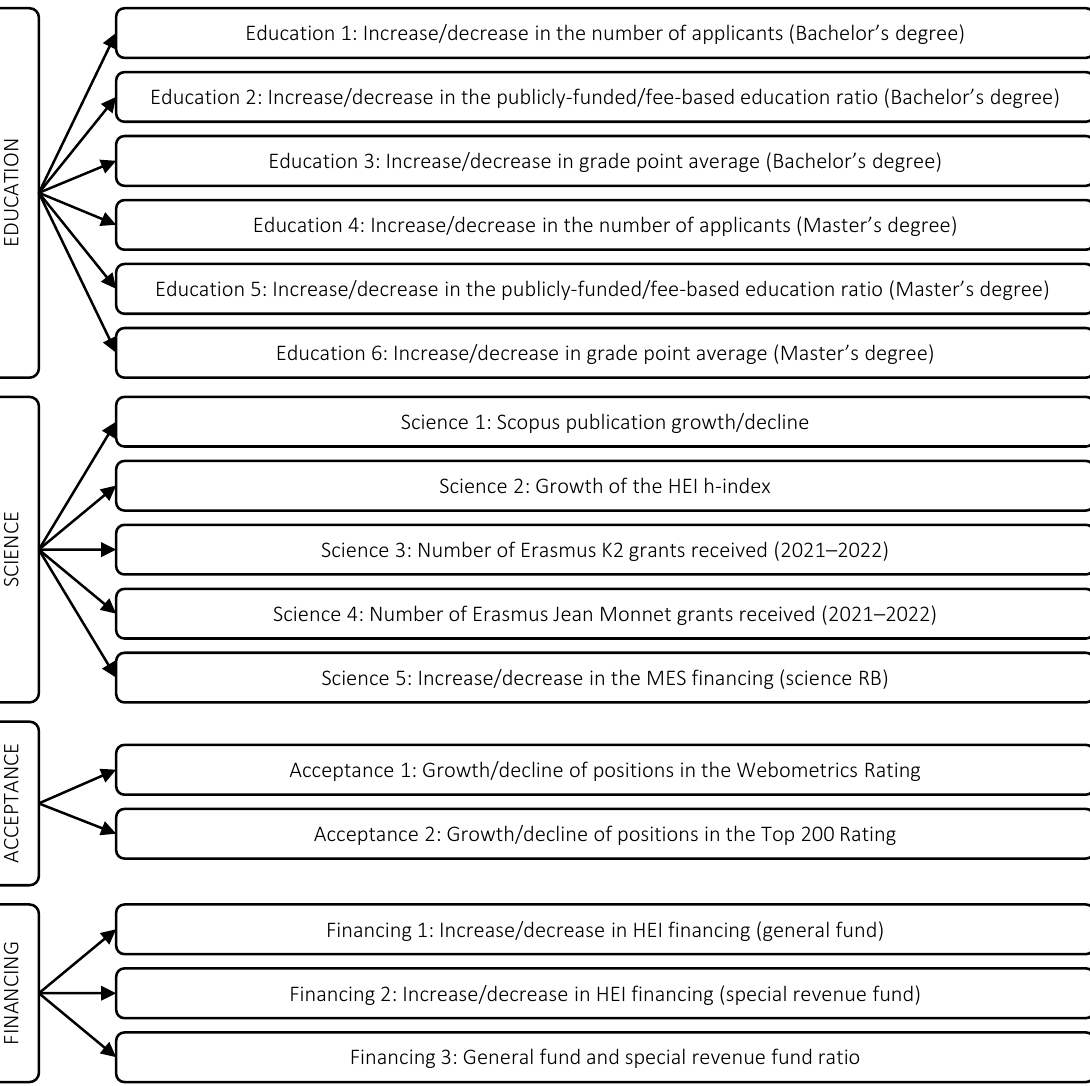
Figure 1. System of indicators for determining the University Integrated Sustainability